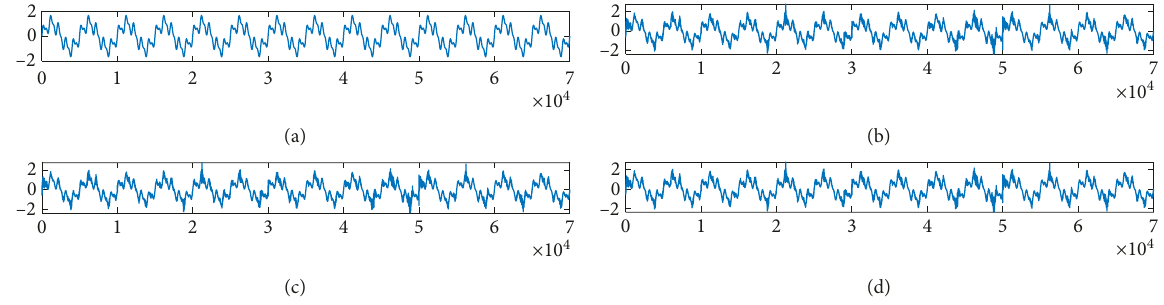
n of the improved LMS algorithm with signal mutation when (a) signal, (b) α ( )